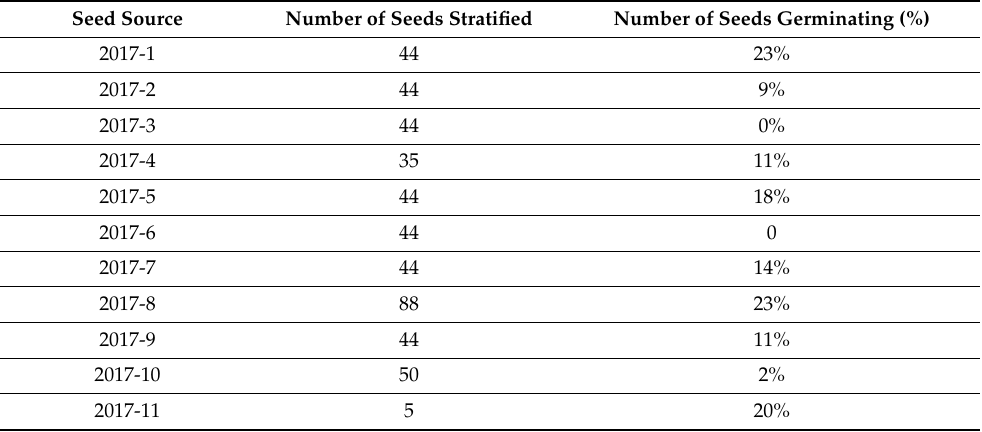
Table 10. Xerophyllum asphodeloides seed germination after 14–16 weeks of stratification at 4–5 ◦ C in wet sphagnum